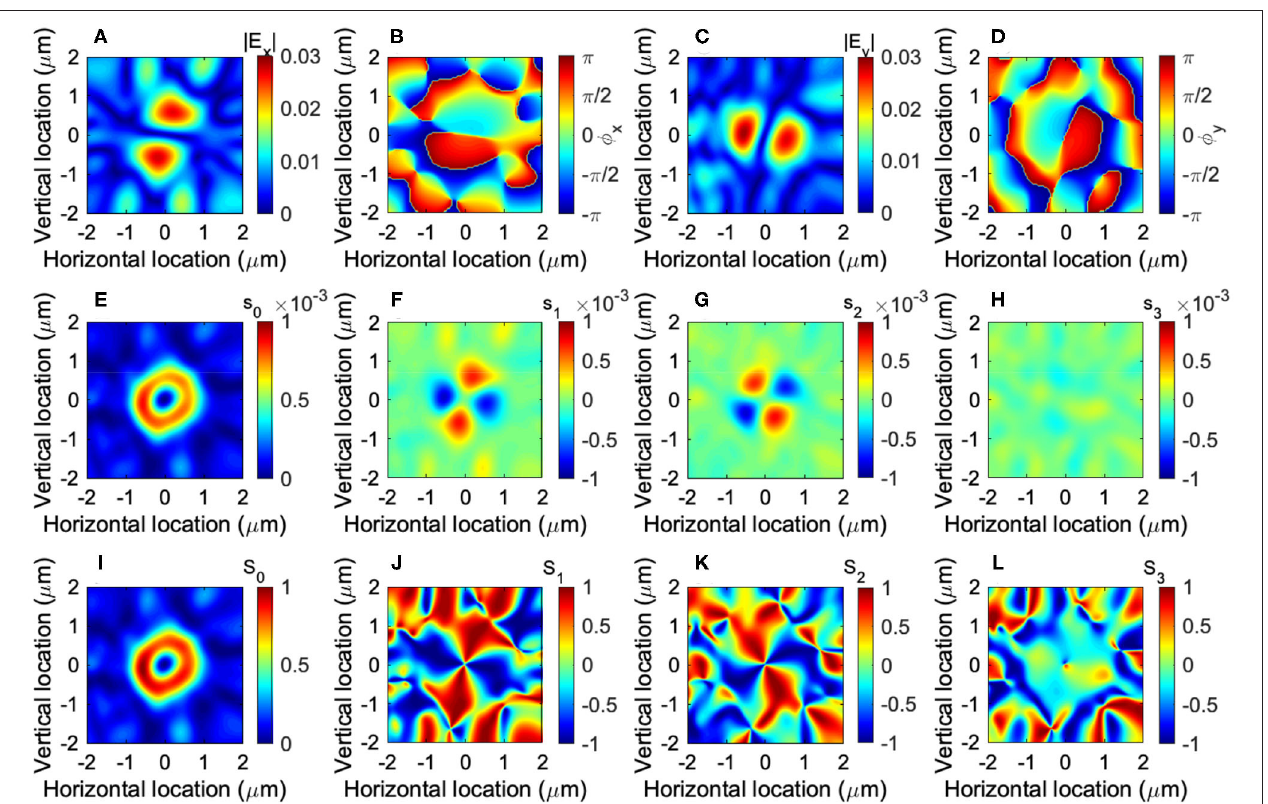
E x ) and (B) the phase ( φ x ) of the | |